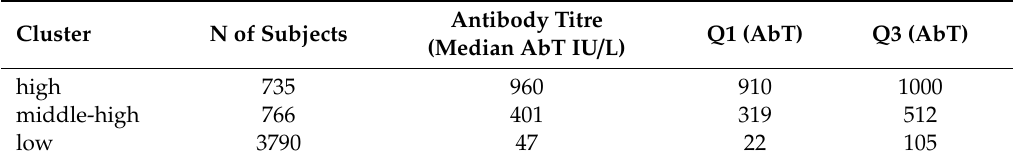
Table 3. K-means cluster analysis procedure, as applied to the whole data set, generated an optimal three-cluster partition explaining the major part of variability (94%) among the 5291 subject population. We could identify the presence of clear discrete “vaccination response” groups.